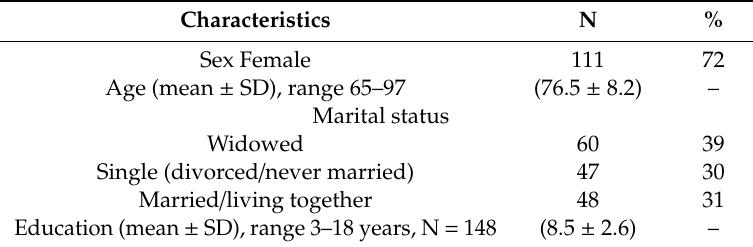
Table 1. Characteristics of the sample (N =